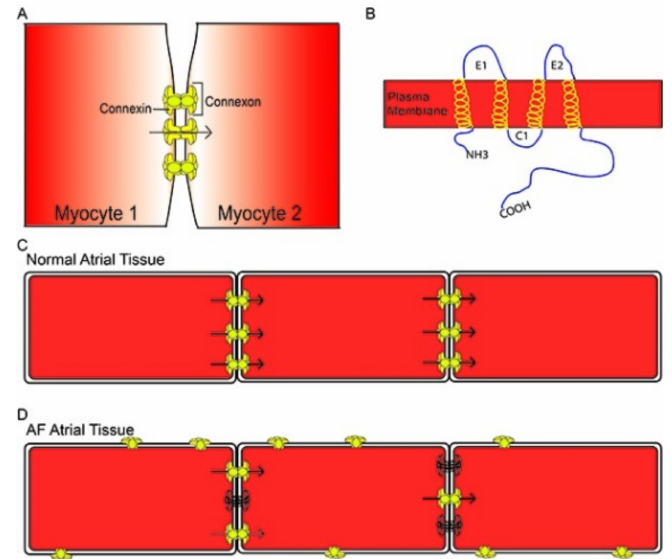
Figure 5. ( A ): Graphical depiction of myocyte-to-myocyte communication through connexin pro- teins at intercalated discs located at the ends of the cells. ( B ): Graphical depiction of structure of connexin protein in relation to plasma membrane. ( C ): Connexin distribution in normal atrial tissue. ( D ): Lateralization of Cx proteins away from intercalated discs, leading to aberrant communication between cardiomyocytes. Reproduced from Jennings and Donahue [56] under a Creative Commons Attribution 3.0 Unported